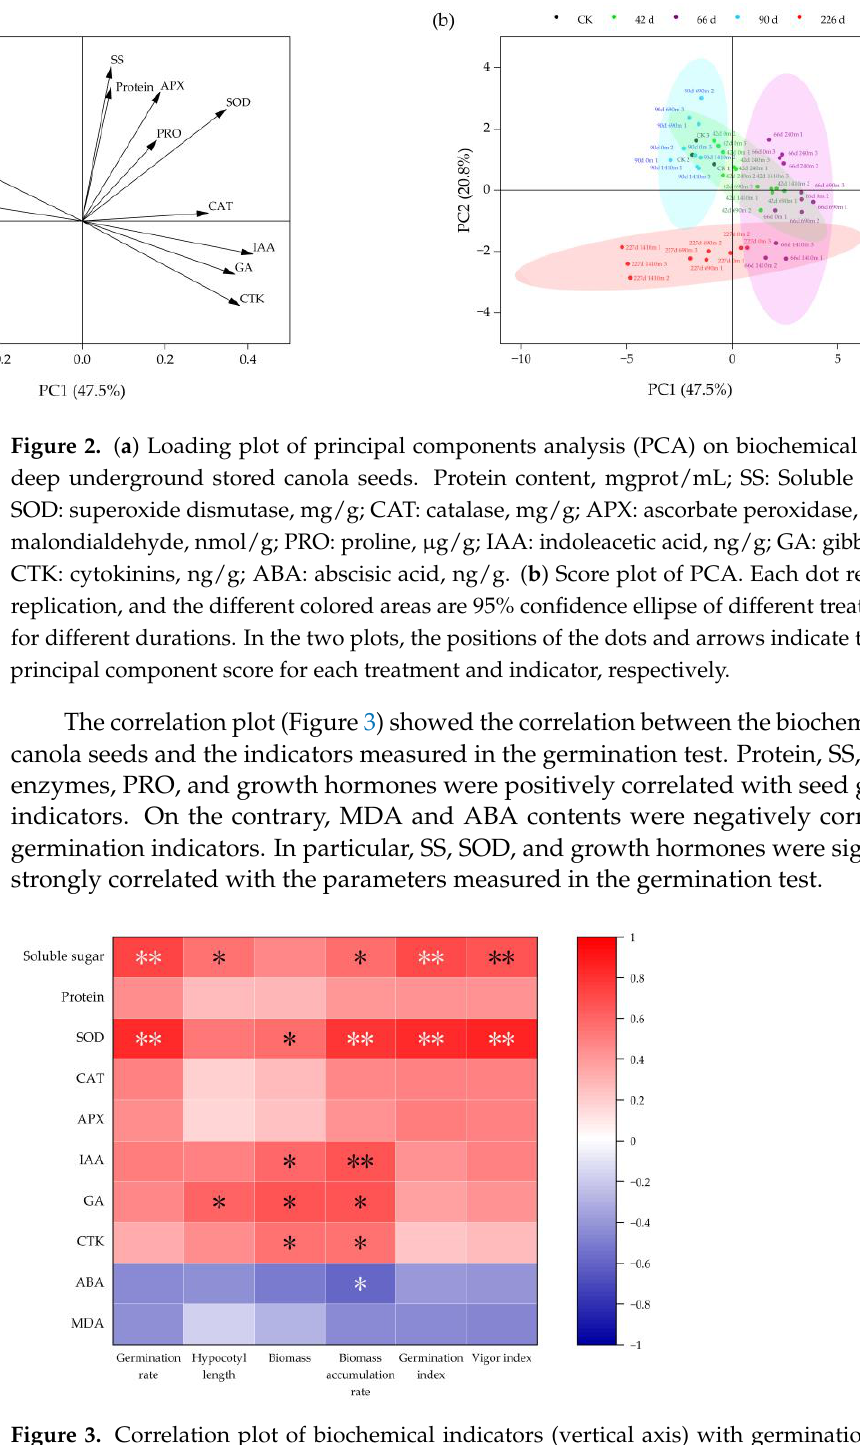
Figure 3. Correlation plot of biochemical indicators (vertical axis) with germination test results (horizontal axis). The germination test results adapted from Reference [4]. 2022, Springer Nature. Red areas indicate positive correlation, blue areas indicate negative correlation, darker colors indicate that the absolute value of the correlation coefficient between the two indicators is closer to 1. Asterisks indicate significance, * Significant at p ≤ 0.05, ** Significant at p ≤